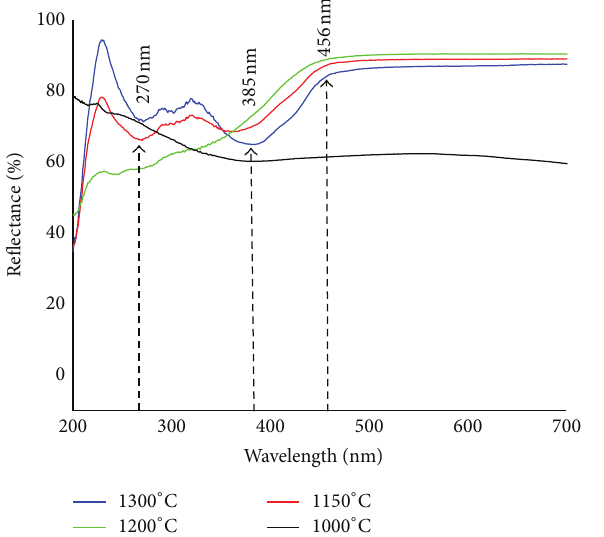
Figure 4: Plot of the Kubelka-Munk functions versus energy in eV for all samples annealed at different temperatures. The dashed lines are the tangent lines related to the procedure for the estimation of the band-gap energy; the intersection of the dashed lines with the horizontal axis gave us the values of the band-gap